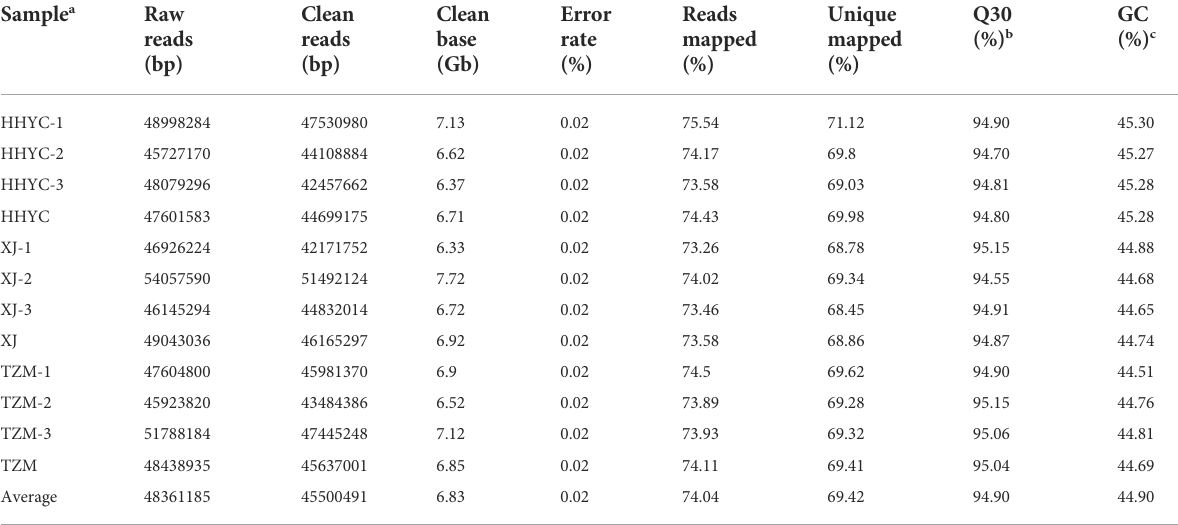
TABLE 2 Summary of RNA-Seq data and mapping metrics of three contrasting fl owers of C. reticulata . Sample